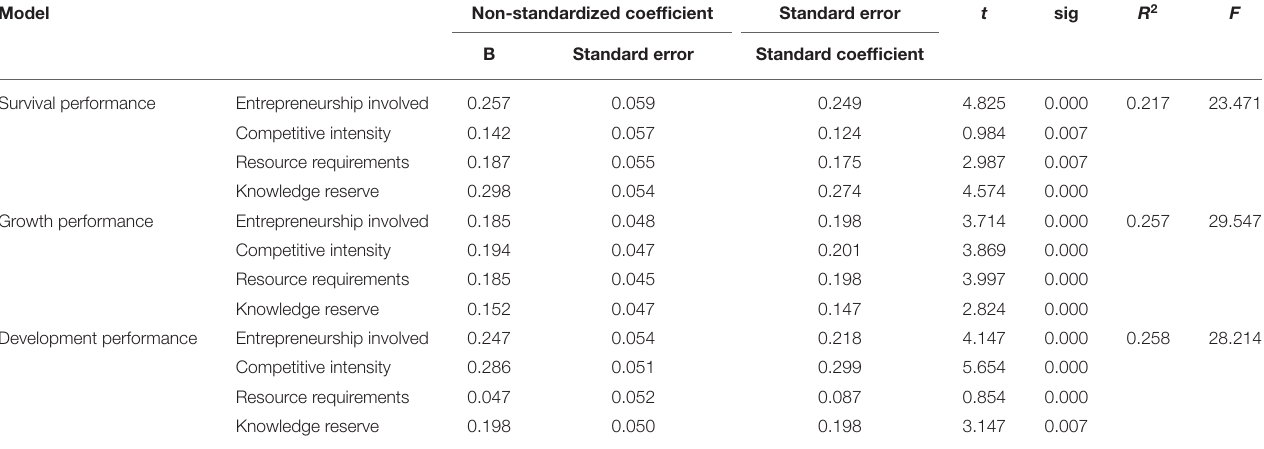
TABLE 11 | Regression analysis of entrepreneurial stress dimensions and new venture performance of new venture entrepreneurs.